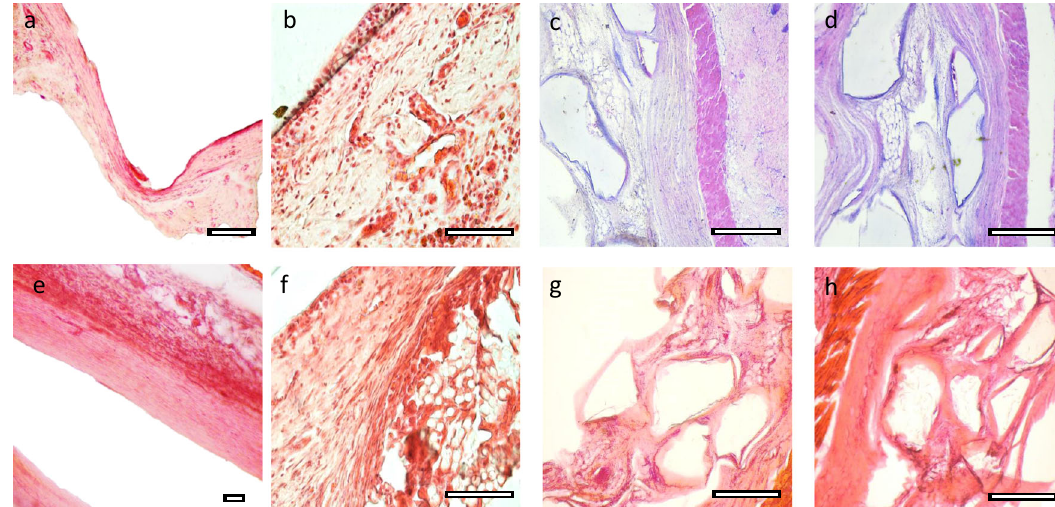
Fig. 7 Histopathological analysis. Representative histological images from PLLA control materials at 1 month ( a ) and 4 months ( e ) compared with PTMPTCX fi lms at the same times ( b , f ). Masson ’ s Trichrome ( c , d ) and H&E ( g , h ) images of PTMPTCX ( c, g ) and PNTCTX ( d , h ) printed scaffolds after 4 months, respectively, with corresponding histological scoring and assessment. Scale bar = 200 µ